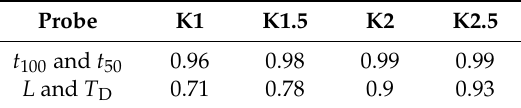
Table 2. Pearson correlation coe ffi